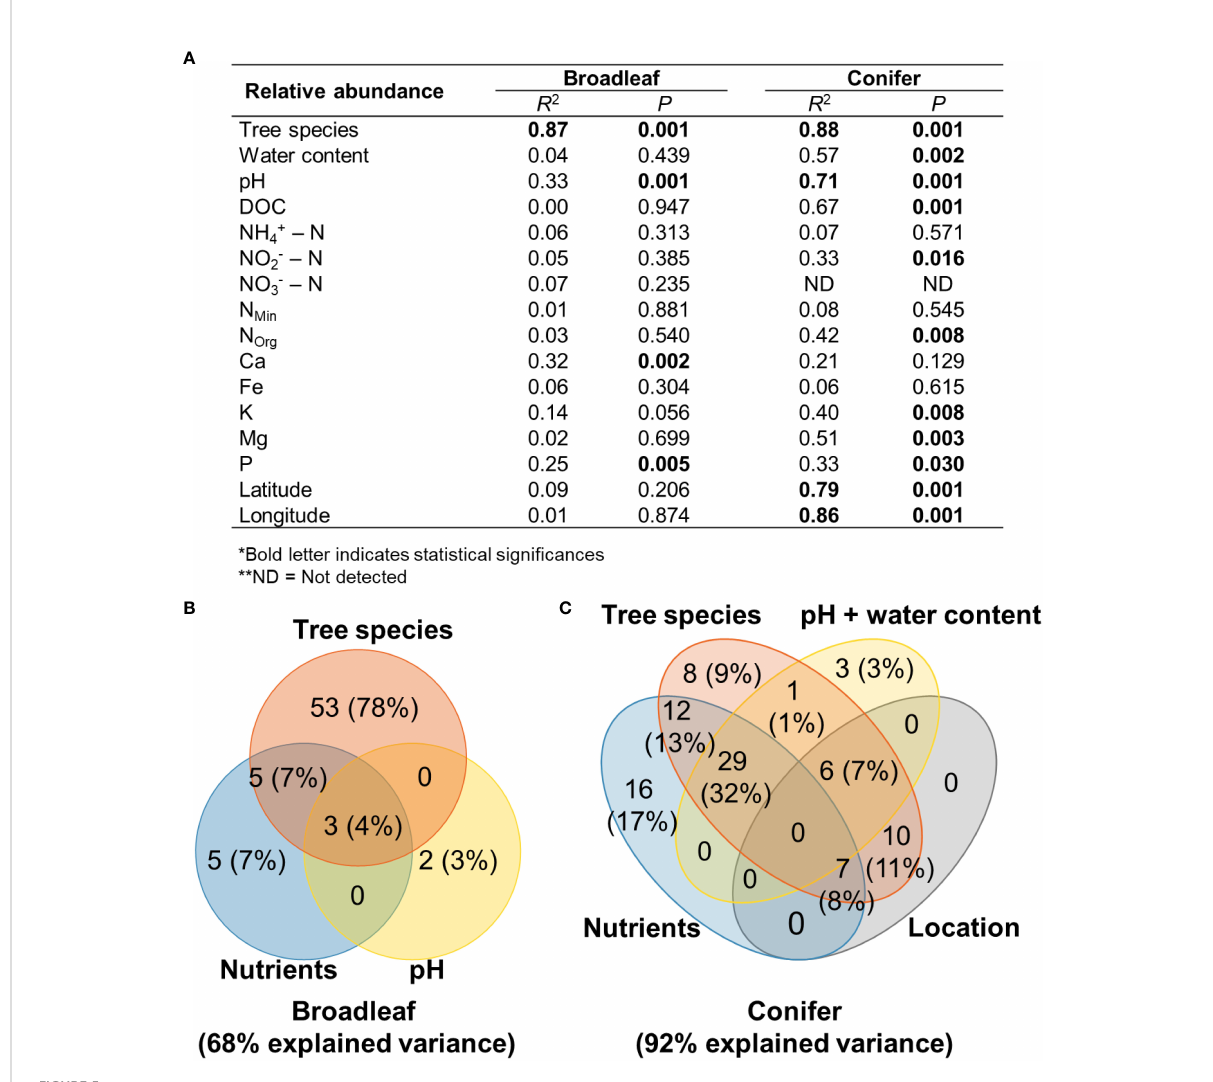
FIGURE 5 Goodness-of- fi t statistics ( R 2 ) of environmental variables fi tted to NMDS ordination of fungal plant pathogenic community based on relative abundance data and Bray – Curtis distance measure (A) , Venn diagrams showing the contributions of the factors shaping fungal plant pathogenic community (B, C) . Nutrients evaluated in the analysis of broadleaf trees were Ca and P. Nutrients evaluated in the analysis of coniferous trees were DOC, NO − 2 , N org , K, Mg, and P. The number and percentage in the parentheses in the Venn diagram indicate the explained variance and its percentage in the total explainable variance. *Bold letter indicates statistical signi fi cance, ** ND, Not